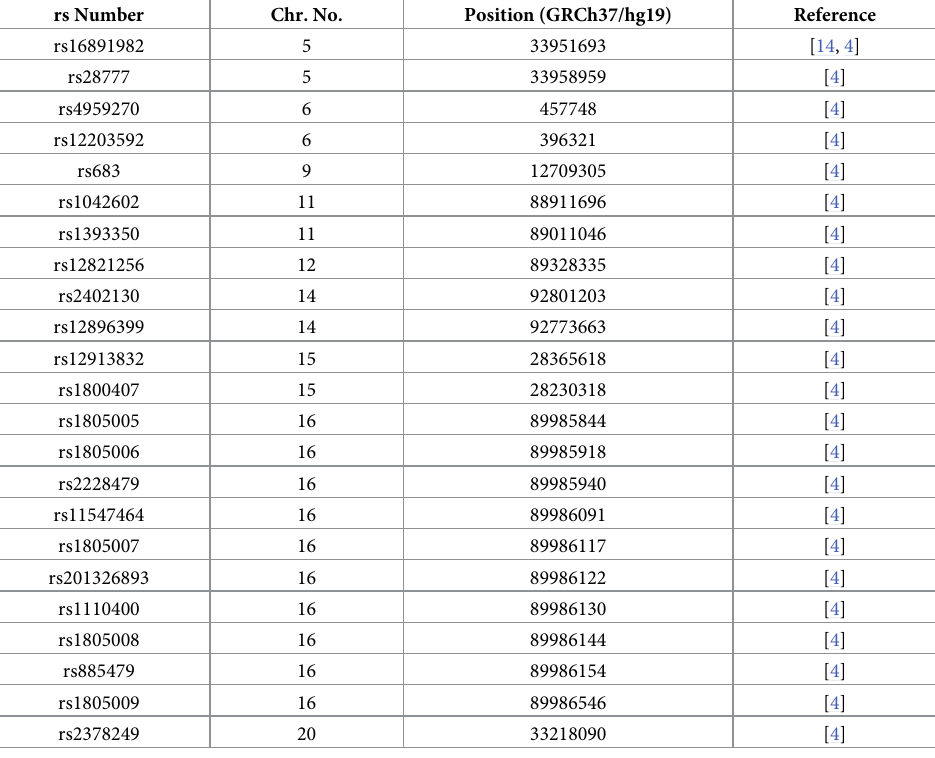
Table 2. Details of the 23 phenotype (hair and eye colour) SNPs included in the hybridisation enrichment panel. SNP rs16891982 is also included in the ancestry SNPs. rs Number Chr.